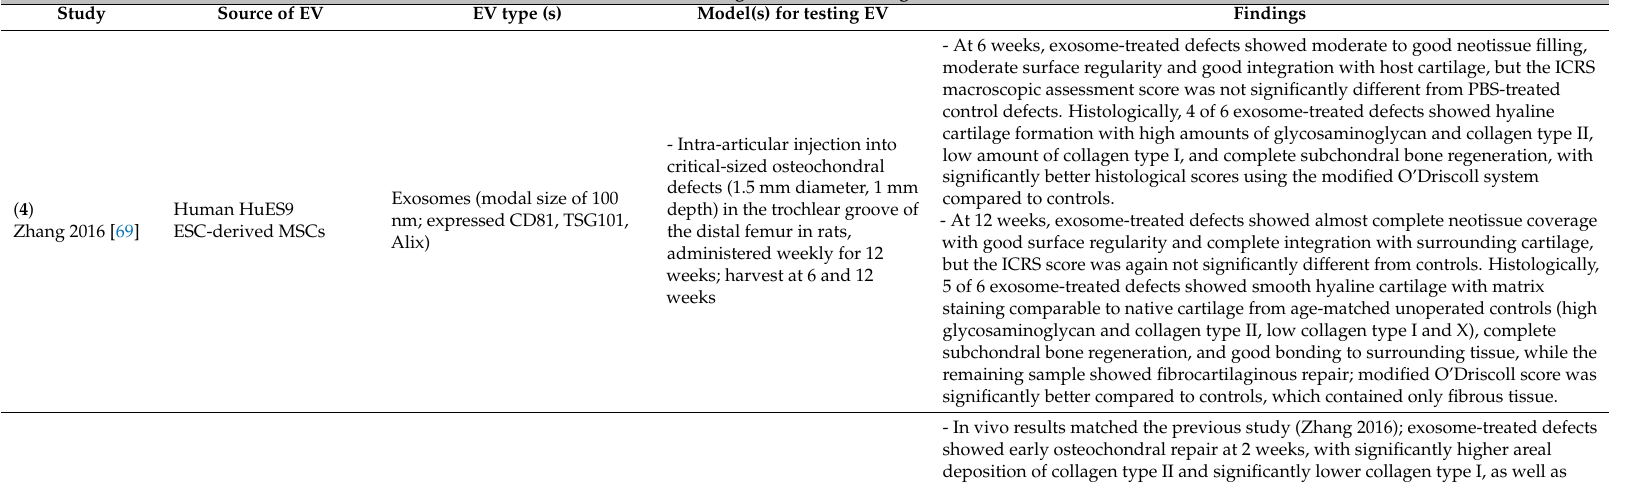
(4) Effects of EVs on the regeneration of cartilage/osteochondral tissue